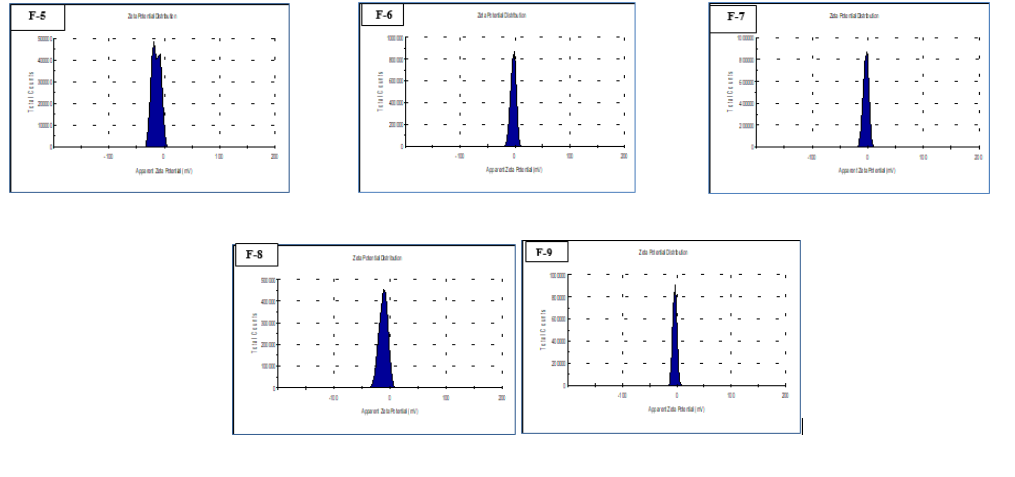
Figure 8. Zeta potential values of LCDP nanoemulsions formulas(5,6,7,8and 9) respectively .